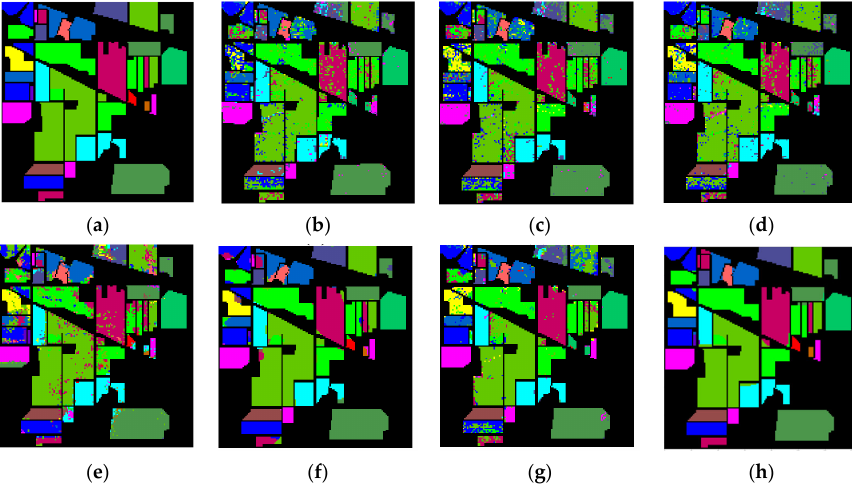
Figure 4. Visualization of the classification results on the Indian Pines dataset. ( a ) Ground Truth. ( b ) RBF-SVM. ( c ) DBN. ( d ) SAE. ( e ) CNN. ( f ) 3DCNN. ( g ) PPF-CNN. ( h ) ARL-GAN. PaviaU: The classification results of the PaviaU dataset are shown in Table 5. Under Table 5. Classification comparison results of ARL-GAN with different algorithms on the PaviaU